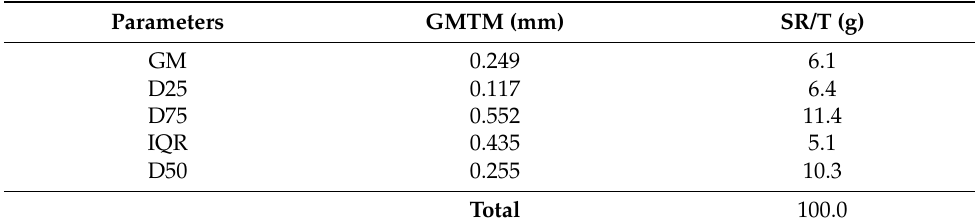
Table 4. D. villosa root, powdered-particle size distribution. Parameters